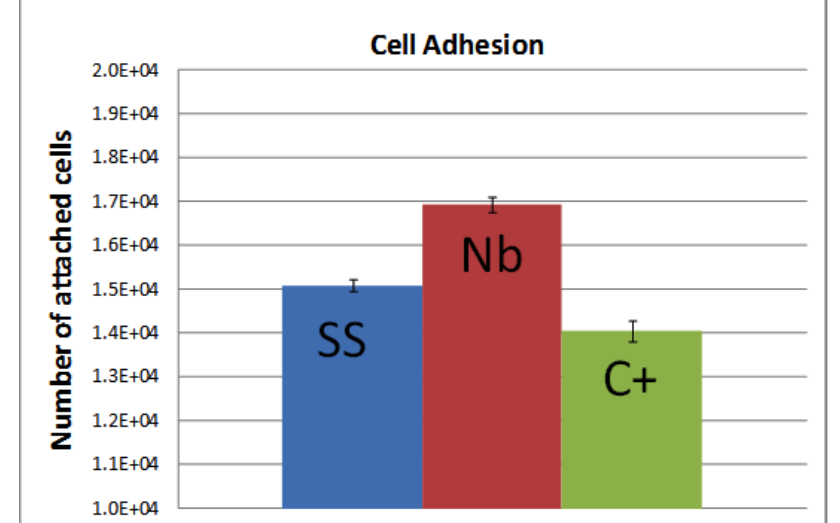
Figure 5. Absolute numbers of attached cells after 24 hour of incubation for the control (C+), the substrate and the Nb film. Statistics using the one-way ANOVA showed that Nb results are significantly different to SS and C+ (p < 0.001).